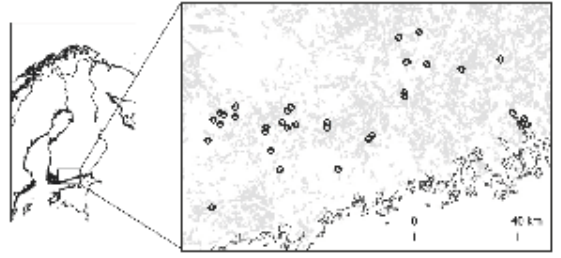
Figure 1. Locations of the 34 study fields (characterised in Tab. 1) in Southern Finland. Arable land is shown in the map in grey